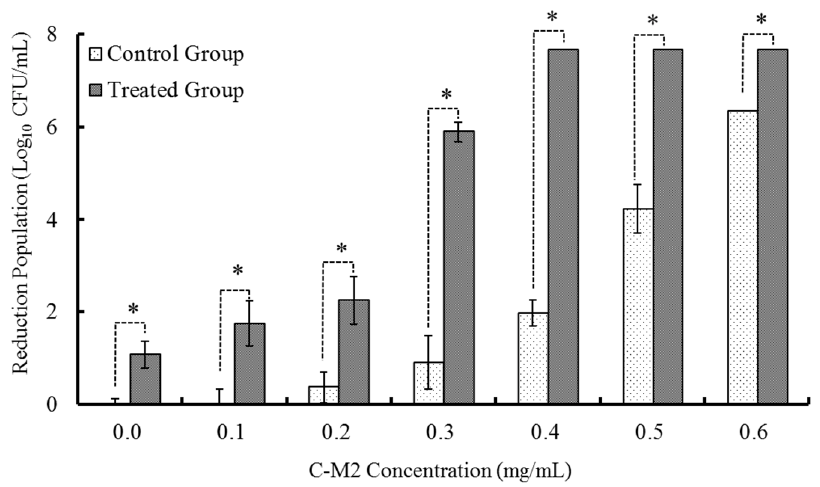
Figure 1. Inhibitory effect of bacteriocin Lactocin C-M2 on Morganella sp.wf-1. Statistically significant finding at * p < 0.05 compared with their respective controls of same concentration.